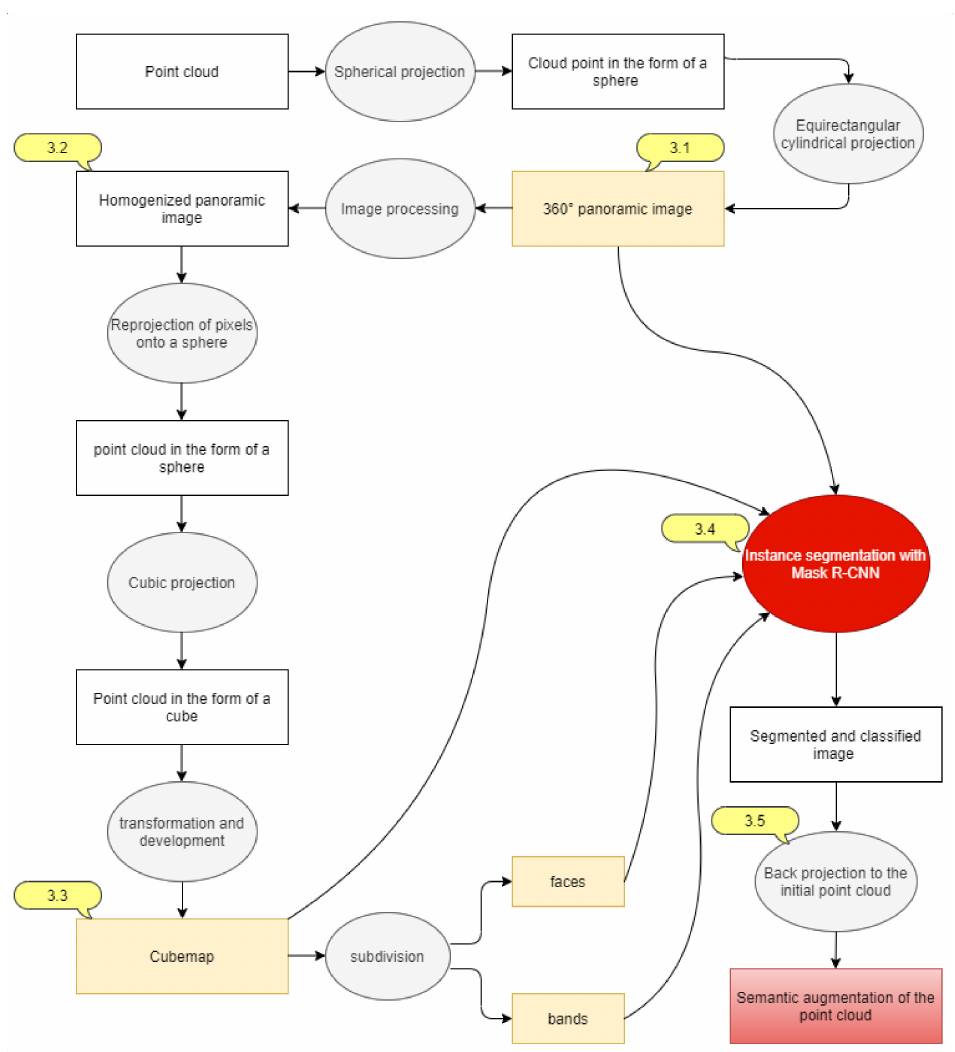
Figure 1. General methodological